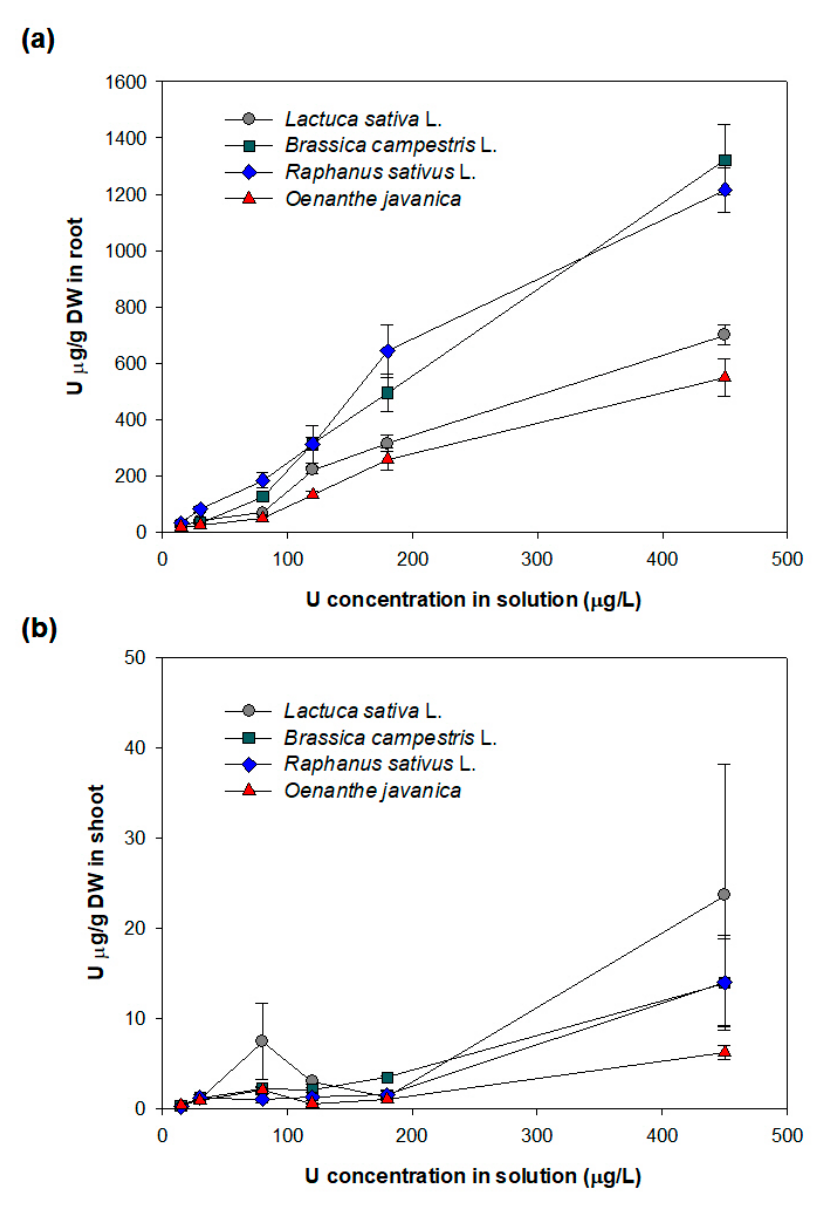
Figure 1. Uranium accumulation in the roots ( a ) and shoots ( b ) of four different plant species after 72 h of treatment with solutions with different concentrations (15, 30, 80, 120, 180, and 450 µ g/L). shown in Figure 3. The average uranium BCF values of all species are 6820.9 at pH